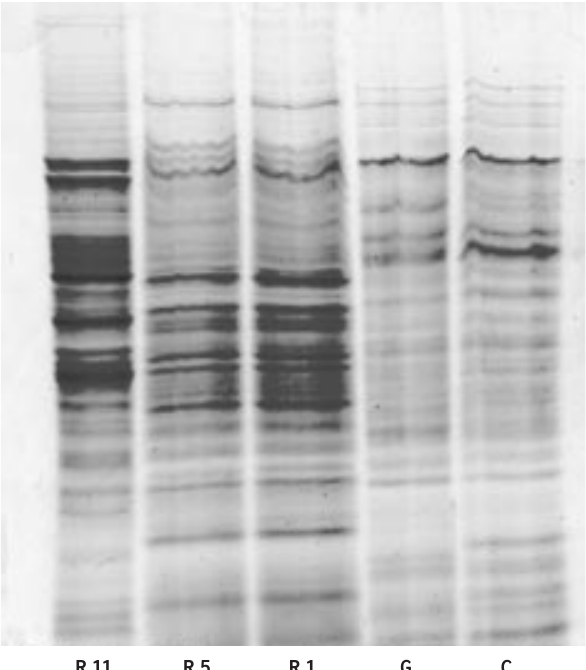
R11 R5 R1 G Figura 3. Perfil eletroforético de proteínas totais solúveis dos isolados de rizóbios R1, R5 e R11 e de estirpes de crescimento lento, recomendadas para guandu (G) e caupi (C), provenientes da Embrapa Agrobiologia.